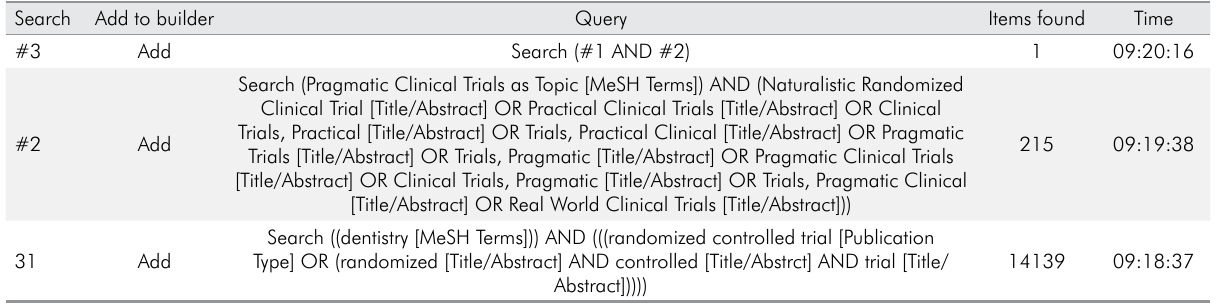
Table. Search strategy used to identify pragmatic clinical trials and the results from searching in Pubmed database. Search Add to builder Query Items